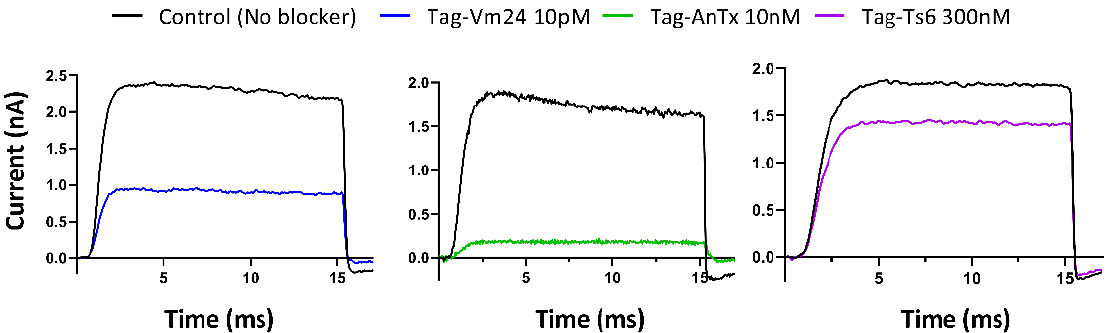
Figure 4. Inhibition of hKv1.3 currents by tagged recombinant Vm24, AnTx, and Ts6. These peptides are indicated in the figure as Tag-Vm24, Tag-AnTx, Tag-Ts6. Whole-cell currents through hKv1.3 were evoked from activated human peripheral T lymphocytes by depolarization to +50 mV from a holding potential − 120 mV for 15 ms duration. Test pulses were applied every 15 s. Representative traces show the K + current before the application of toxin (control) and after reaching the equilib- rium block in the presence of Tag-Vm24 (blue), Tag-AnTx (green), and Tag-Ts6 (purple). Table 1. Initial characterization of the recombinant Vm24, AnTx, and Ts6.